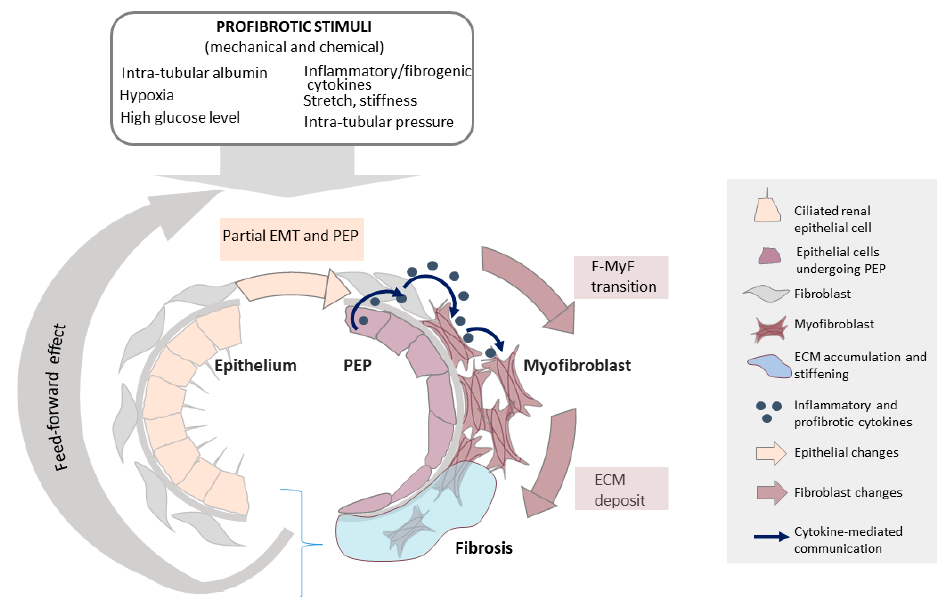
Figure 4. Profibrotic epithelial phenotype (PEP) drives fibrosis. Epithelial injury can be secondary to mechanical forces (stretch and stiffness, intratubular pressure) or chemical insults (high glucose level, hypoxia), that result in the loss of cell-cell contacts, and inflammation. Together, these events drive a partial epithelial-to-mesenchymal transition, and the acquisition of the consequent profibrotic epithelial phenotype (PEP), characterized by increased production and secretion of profibrotic cytokines. PEP cells communicate with the adjacent stroma via the released cytokines (epithelial-mesenchymal crosstalk), that stimulate fibroblast-to-myofibroblast transition (F-MyF). Myofibroblasts secrete additional cytokines that trigger their proliferation, while they also deposit ECM components, leading to stiffening. On the other hand, PEP reinforces profibrotic stimuli, creating a feed-forward loop of injury, reinforcement of PEP and accelerated fibrosis.